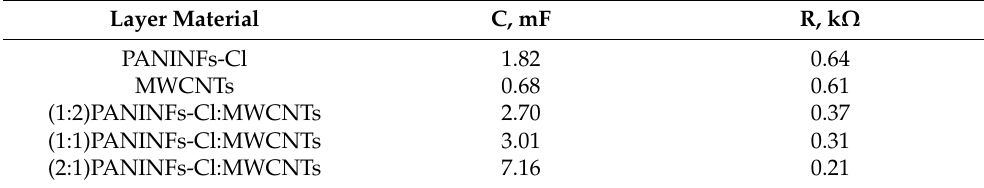
Figure 2. Chronopotentiometric curves obtained for the layers of ( A ) PANINFs-Cl and MWCNTs; ( B ) nanocomposites PANINFs-Cl:MWCNTs. Table 1. Estimated values of electric capacitance (C) and resistance (R) for the tested solid-contact layers determined by chronopotentiometry.